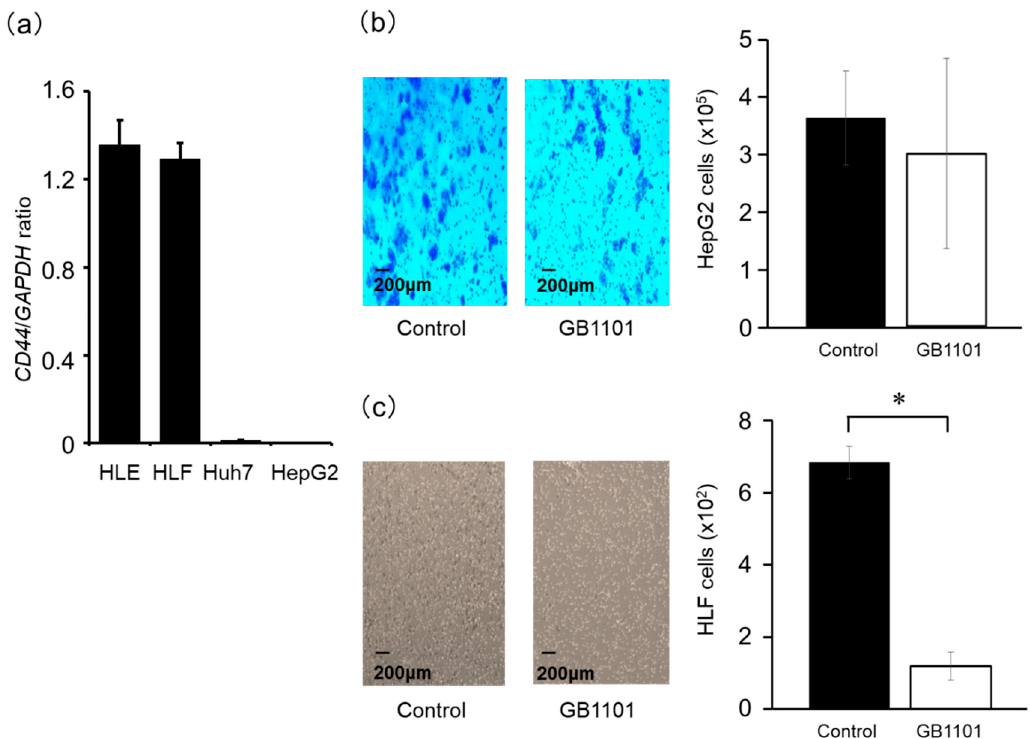
Figure 3. CD44 expression of hepatocellular carcinoma cells, and e ff ect of GB1101 on the invasion capacity of hepatocellular carcinoma cells in matrigel invasion assay. ( a ) The relative expression level of CD44 mRNA in four liver cancer cell lines (HLE, HLF, Huh7, and HepG2) was assessed by qPCR. HepG2 and HLF cells were seeded in each invasion chamber at a density of 5 × 10 5 cells / mL. ( b ) HepG2 cells were treated with 2 µ M GB1101 for 24 h, and ( c ) HLF cells were treated with 3 µ M GB1101 for 9 h. Representative images of invasive cells are shown, and the number of invasive cells are counted and presented as the mean ± SD (n = 3). *, p < 0.01.